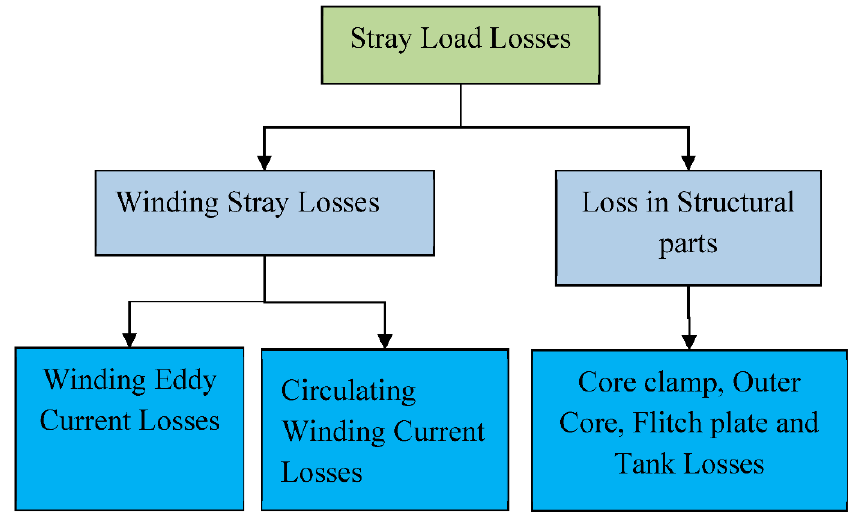
Figure 1. Classification of transformer losses.